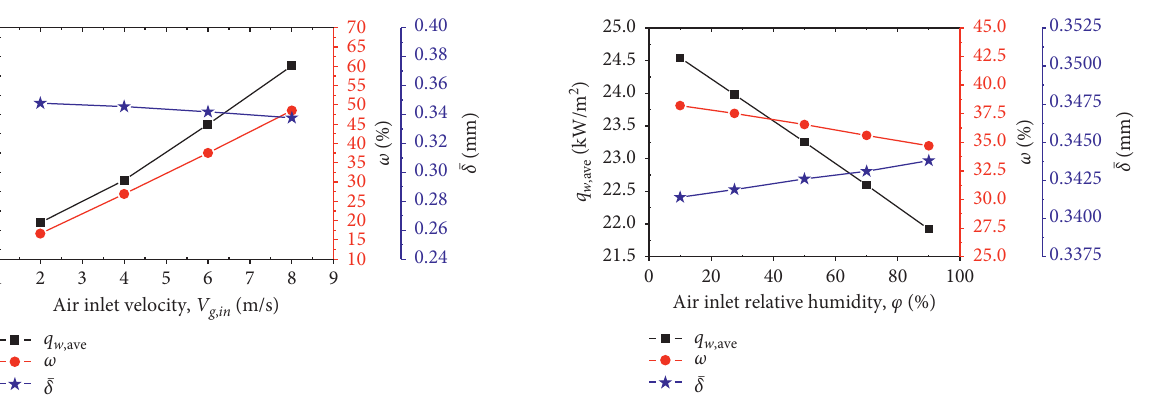
Figure 10: Influence of the air inlet velocity on heat and mass transfer of the water film evaporation process.